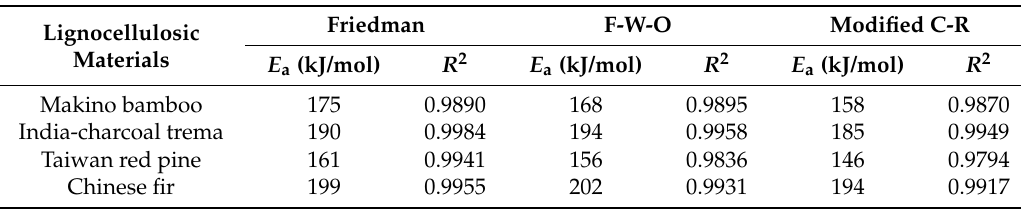
Figure 6. A comparison of apparent activation energies as a function of decomposition conversion rate ( α ) for various lignocellulosic fibers calculated by the Friedman method ( a ); Flynn-Wall-Ozawa method ( b ); and modified Coast-Redfern method ( c ). Table 3. Apparent activation energy of different lignocellulosic fibers calculated by three isoconversional methods at the α = 10%.